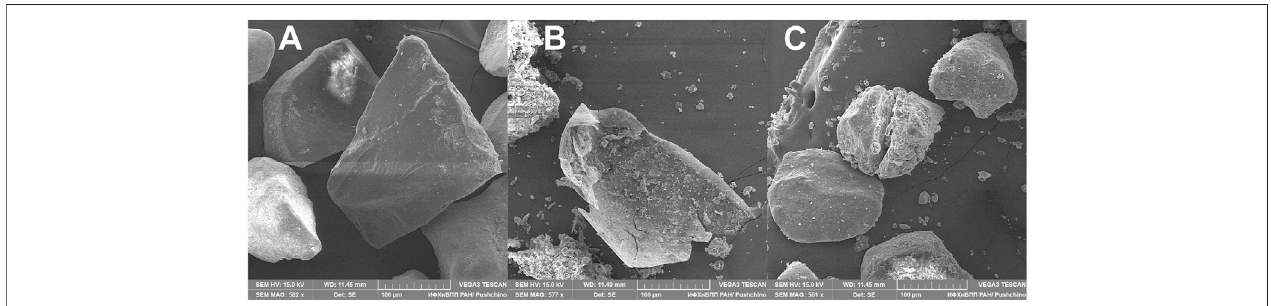
FIGURE 6 | Grain morphology images from a raster electron microscope on the active layer sediments. (A) – fresh quartz surface (Lake Akhmelo, depth 20 cm); (B) – disintegration of cryogenic aggregate (Malchikovskaya channel, depth 10 cm); (C) – disintegration of quartz grain (mouth of the Omolon River, depth 20 cm).